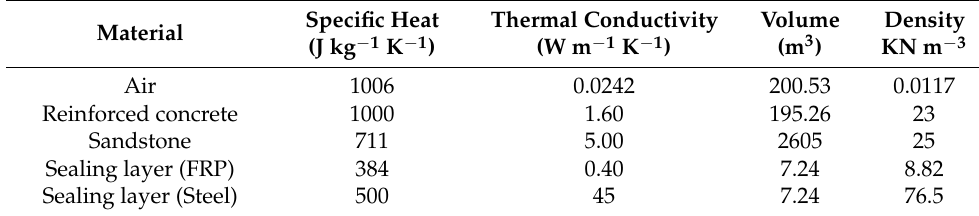
Table 1. Thermal properties and volume of air, concrete, sealing layers and sandstone rock